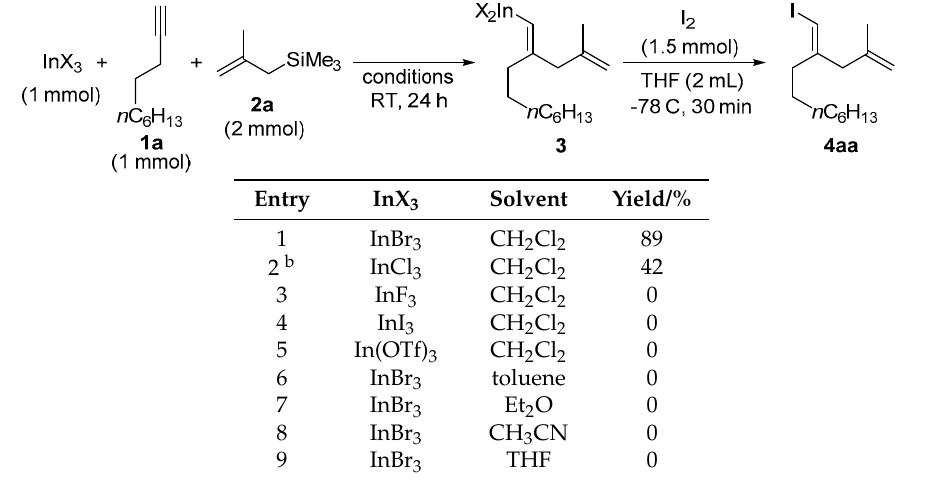
Table 1. Optimization of reaction conditions for carboindation of alkyne 1a with allylic silane 2a a .